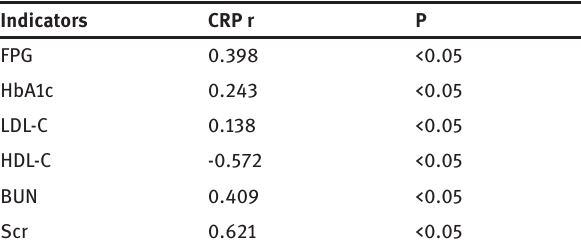
Table 4: Analysis of the correlation between the level ofchemerin of serum and basic